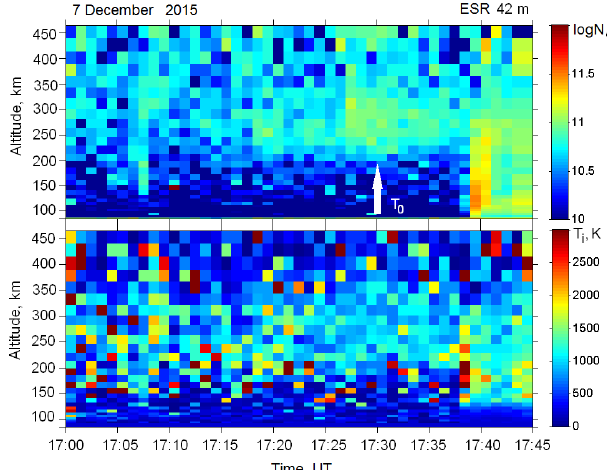
Figure 5. Data of the EISCAT Svalbard Radar (ESR) at Longer- byen, with the electron density N e and ion temperature T i . N e en- hancement at 17:39UT was associated with the coiling structure arriving at the